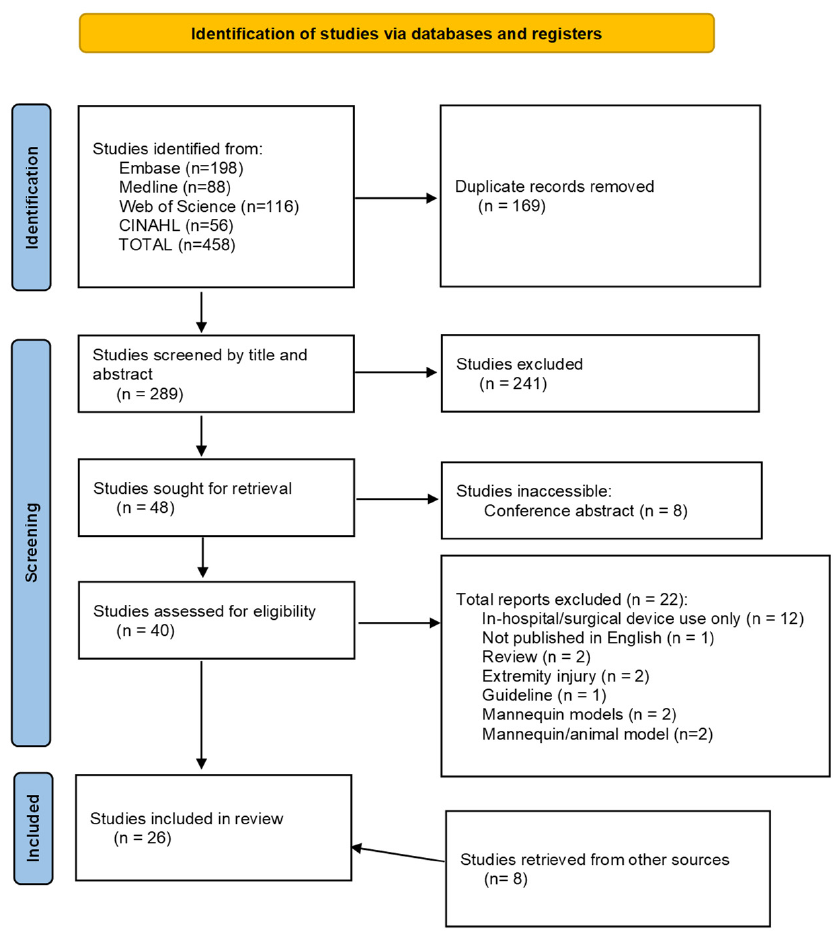
Figure 1. PRISMA flow diagram.